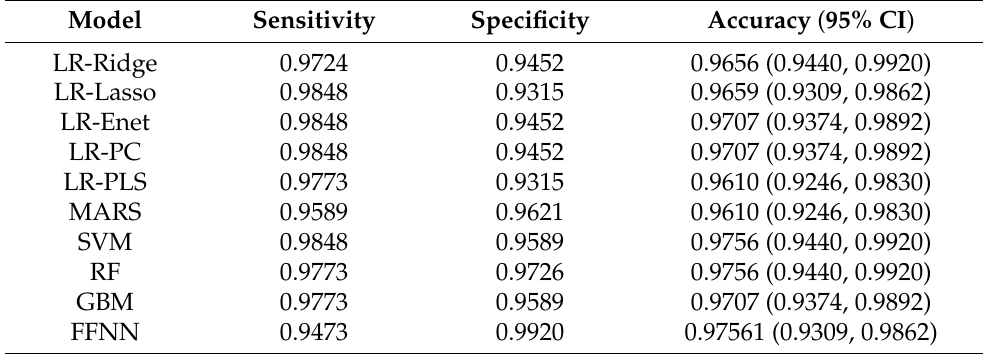
Table 6. All models applied to the breast cancer data.